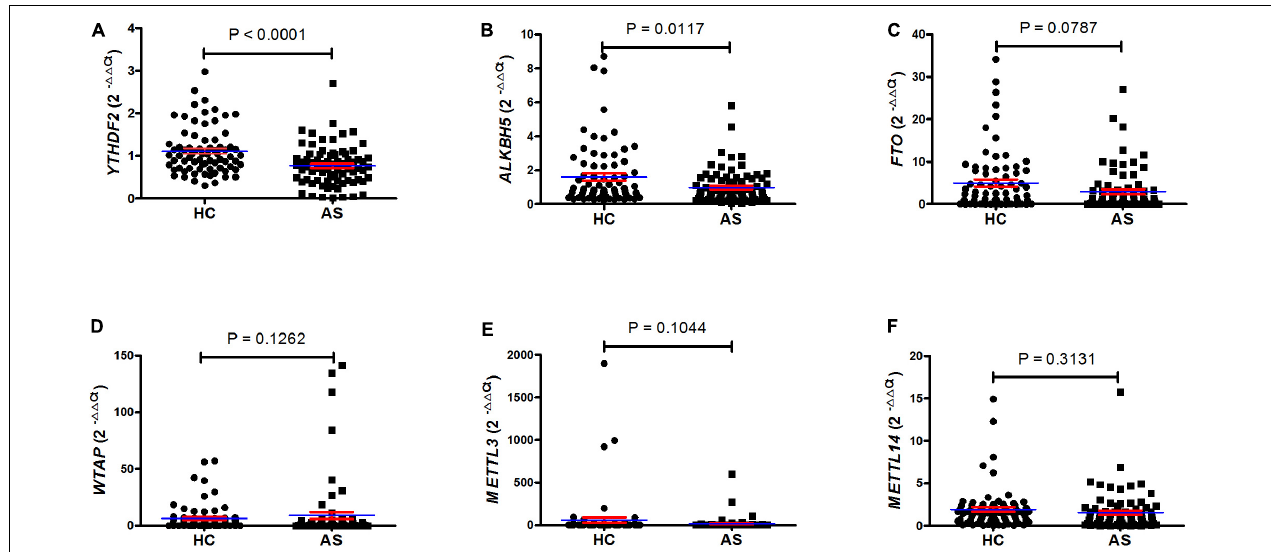
FIGURE 1 | QRT-PCR showed that patients with AS have a lower level of mRNA YTHDF2 and ALKBH5 in PBMC. (A) The level of mRNA YTHDF2 between patients with AS and HC (unpaired t test). (B) The level of mRNA ALKBH5 between patients with AS and HC (Mann–Whitney U test). (C) The level of mRNA FTO between patients with AS and HC (Mann–Whitney U test). (D) The level of mRNA WTAP between patients with AS and HC (Mann–Whitney U test). (E) The level of mRNA METTL3 between patients with AS and HC (Mann–Whitney U test). (F) The level of mRNA METTL14 between patients with AS and HC (Student’s t test). ALKBH5, alkylation repair homolog protein 5; AS, ankylosing spondylitis; FTO, fat mass and obesity-associated protein; HC, healthy control; METTL3, methyltransferase-like 3; METTL14, methyltransferase like 14; qRT-PCR, quantitative real-time PCR; WTAP, Wilms tumor 1-associating protein; YTHDF2, YT521-B homology domains 2. Blue and red lines indicates mean and standard error, respectively.